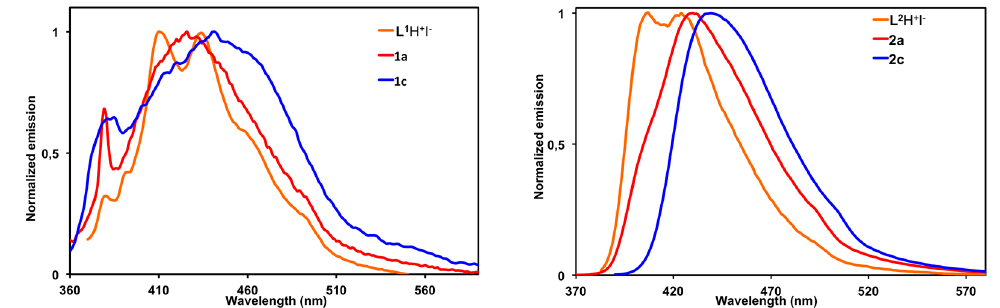
Figure 5. Normalized emission for the azolium salts of L 1 –H + I − , L 2 –H + I − and the carbene metal complexes 1a – 2a and 1c – 2c in CH 2 Cl 2 solution at room temperature.